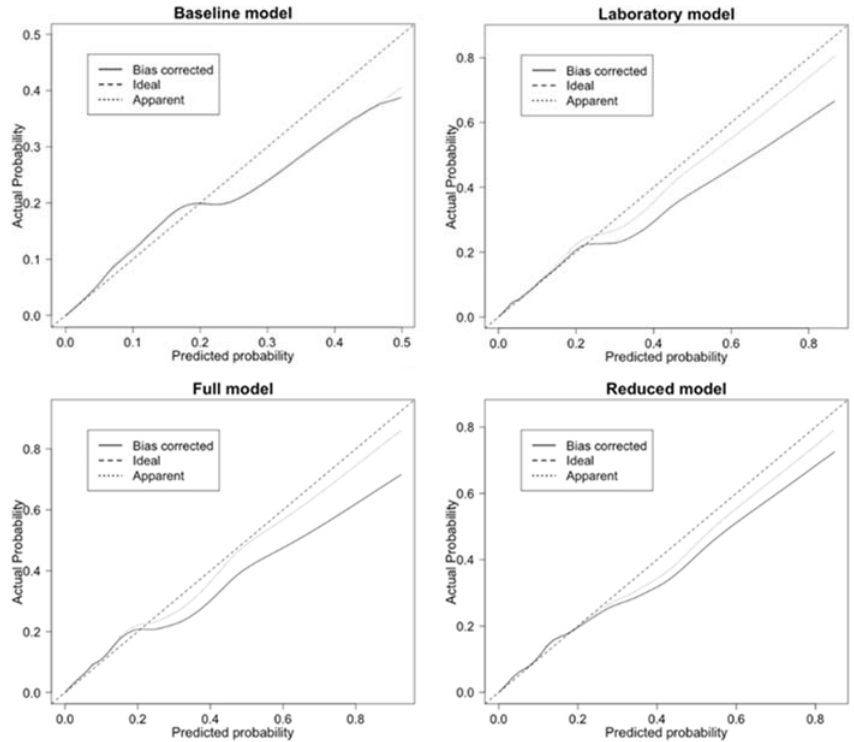
Figure A2. Predicted probabilities versus actual probabilities of in-hospital mortality. Apparent = the model derived from multivariable logistic regression; bias-corrected = model adjusted for overfitting using bootstrapping.